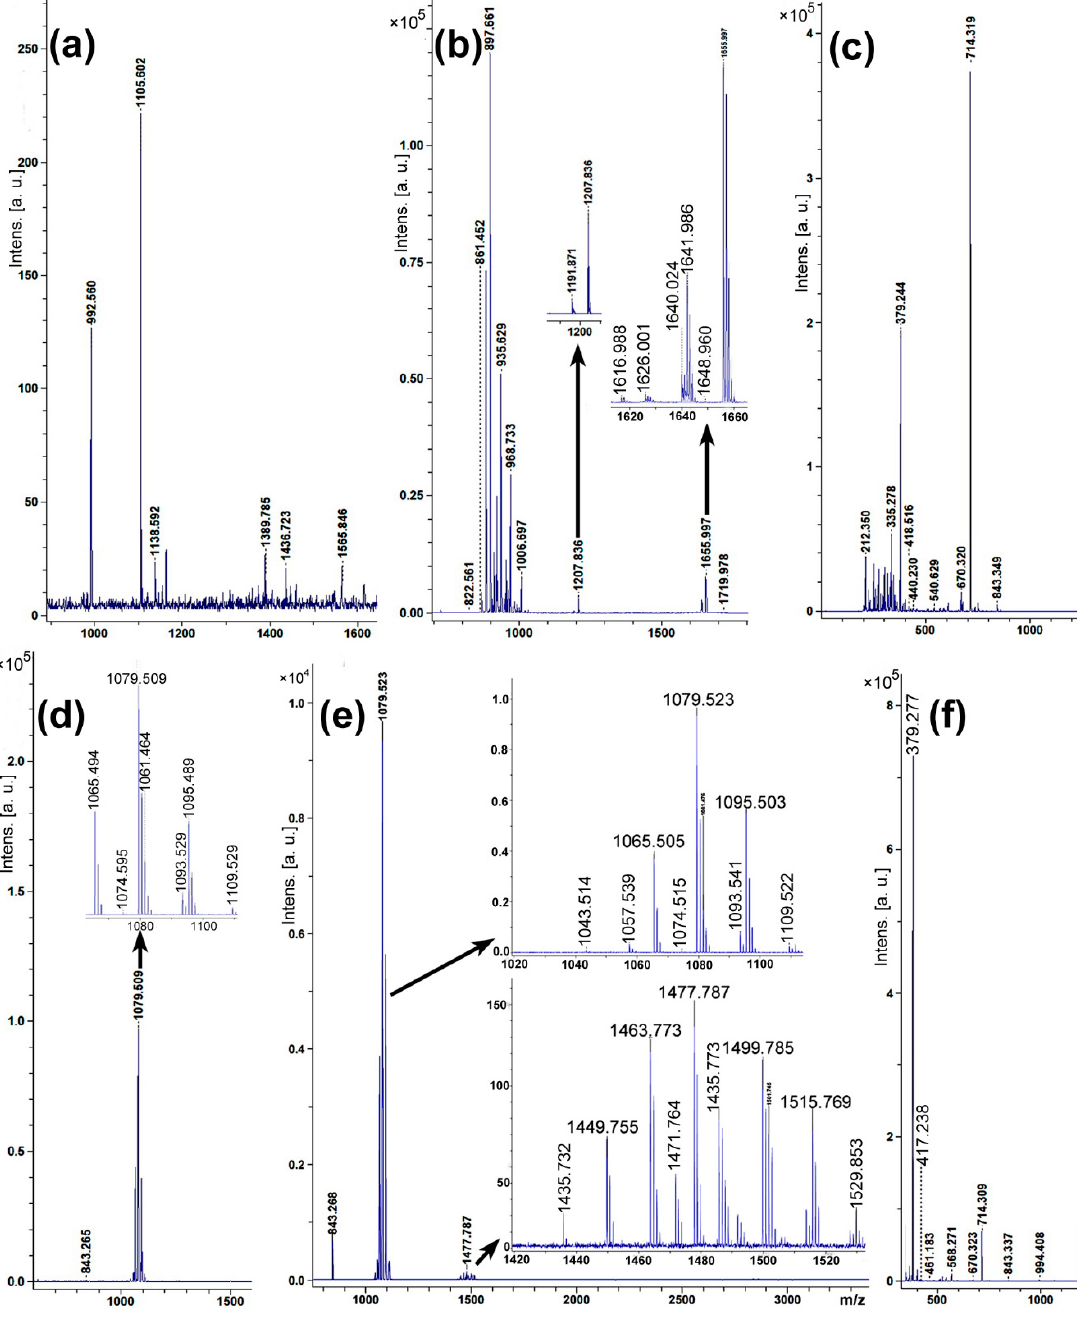
Figure 2. MALDI-TOF MS analysis of the secondary metabolites of P. putida , P. polymyxa and Bacillus spp. ( a ) P. putida IMA3. ( b ) P. polymyxa IMA5. ( c ) Bacillus cereus IMA4. ( d – f ) IMA2, IMA8 and